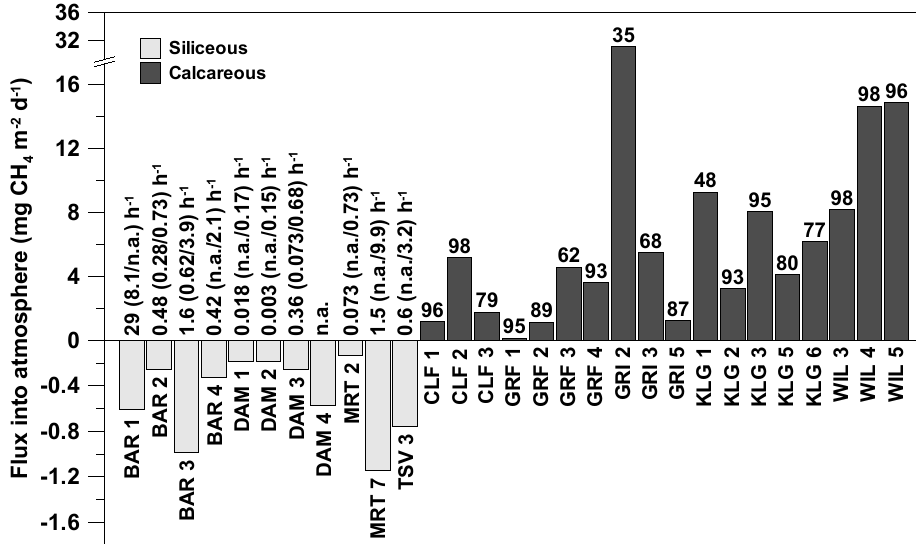
Fig. 2. Fluxes of CH 4 from the soil into the atmosphere ( J atm ) for locations where the profile shape allowed quantification. Negative J atm indicate that the soil was a sink for atmospheric CH 4 . For these locations estimated k of CH 4 oxidation are reported (with low/high 95% confidence interval). For locations with positive J atm , the number above the bars indicates the percentage of CH 4 oxidized in the soil before reaching the atmosphere. Note that the scale for negative and positive fluxes is different. Table 4. Number of samples with successful amplification us- ing different primer combinations during normal (first round) and nested (second round) PCR reactions. The second-round PCR was performed with the product of the first-round primer set A189f- A682r. Total number of samples selected for molecular analyses was